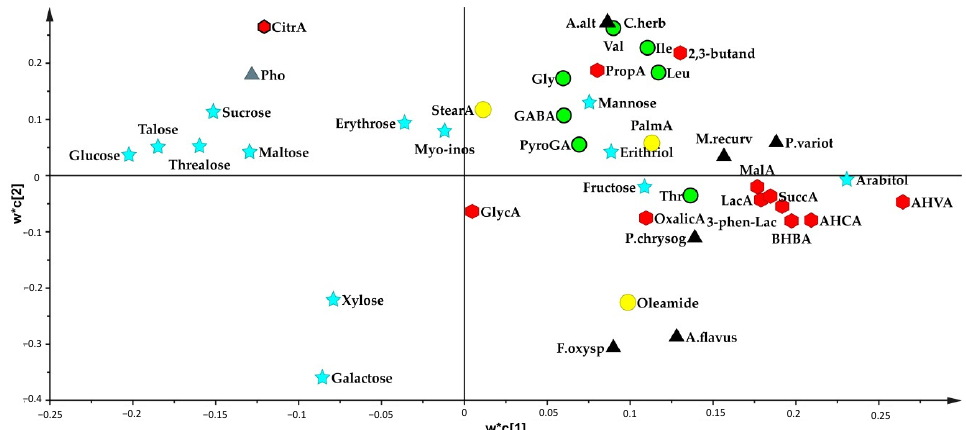
Figure 4. PLS variable loadings plot of GC-MS data (X-variables) superimposed with antifungal activity (Y-variables). R 2 Y = 0.89 and Q 2 Y = 0.65 over 5 validated components. Black triangles = Y coefficients for antifungal activity; red hexagons = organic acids; green circles = amino acids; light blue stars = saccharides and polyols; yellow circles = fatty acids and analogues; black diamond = loadings of Lactobacillus classes. Unknown metabolites are not displayed. Metabolites are abbreviated as in Table